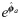
Region-specific effects (top), eϕ^a (posterior medians), and posterior probabilities that the region effect is greater than one, P(eϕ^a>1) (bottom).